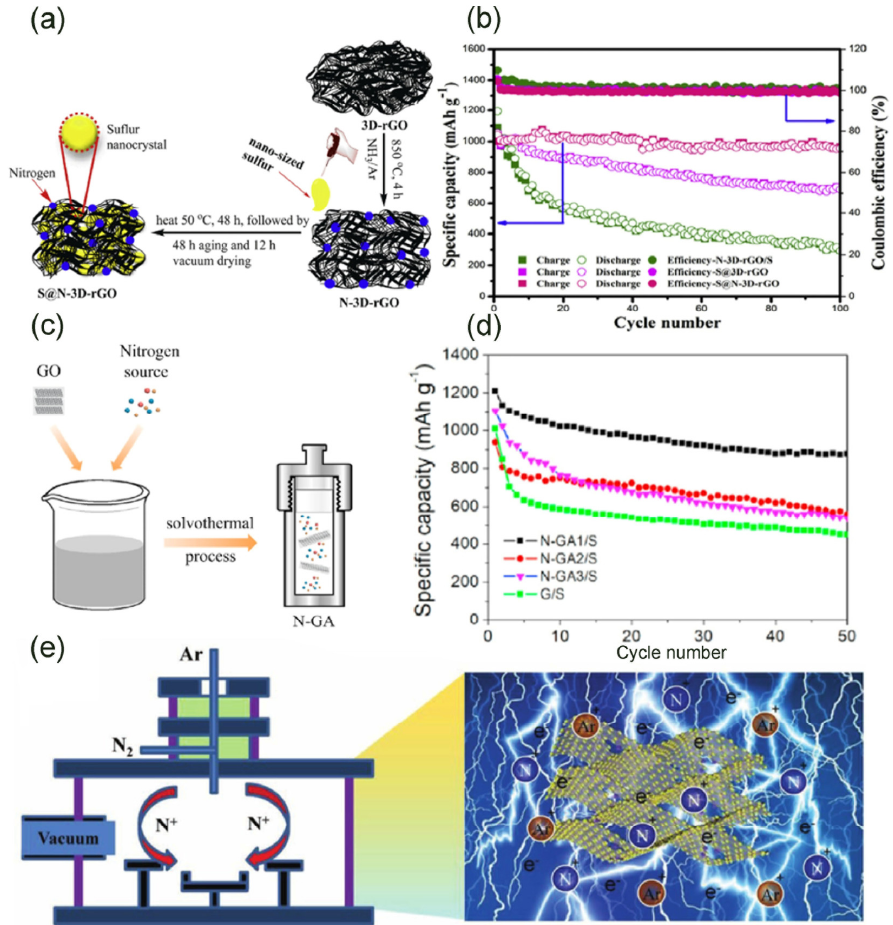
Figure 4. Several methods of NG and the performance of cathode. ( a ) Synthesis of S@N-3D-rGO. ( b ) Cyclic stability and coulombic efficiency of sulfur cathode at 0.2 C [54]. Copyright 2017, Elsevier. ( c ) Hydrothermal synthesis diagram of NG. ( d ) Cyclic performance of sulfur cathode at 0.1 C [57]. Copyright 2021, Elsevier. ( e ) Synthesis diagram of NG by hollow cathode discharge method [55]. Copyright 2019, John Wiley and Sons.